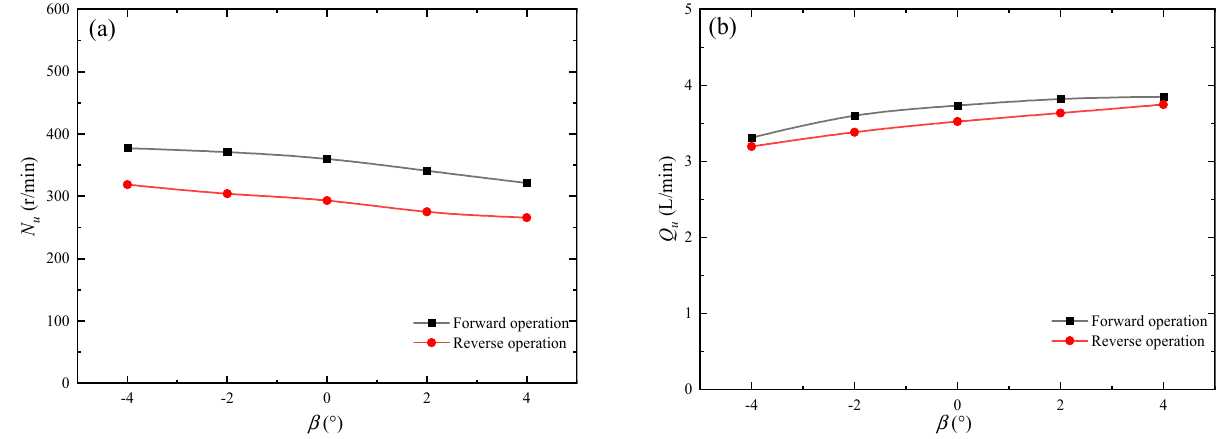
Figure 15. Runaway characteristics of the pump in forward and reverse operations: ( a ) runaway speed; ( b ) backflow rate.